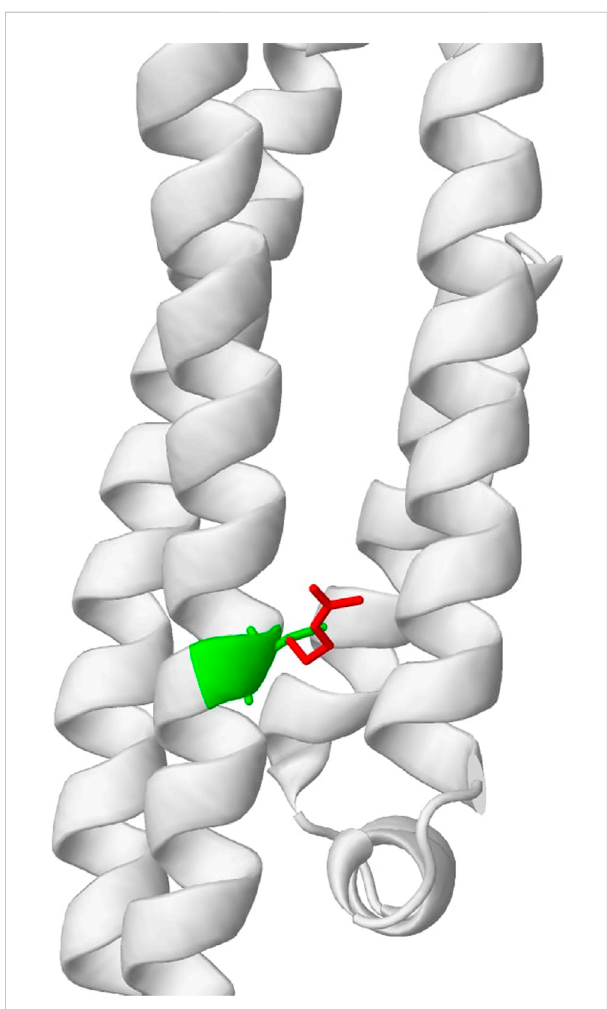
FIGURE 5 PredictedchangeinresiduepropertiesbetweenCysteine(green) and Arginine (red) in C130R variant by Missense3D.